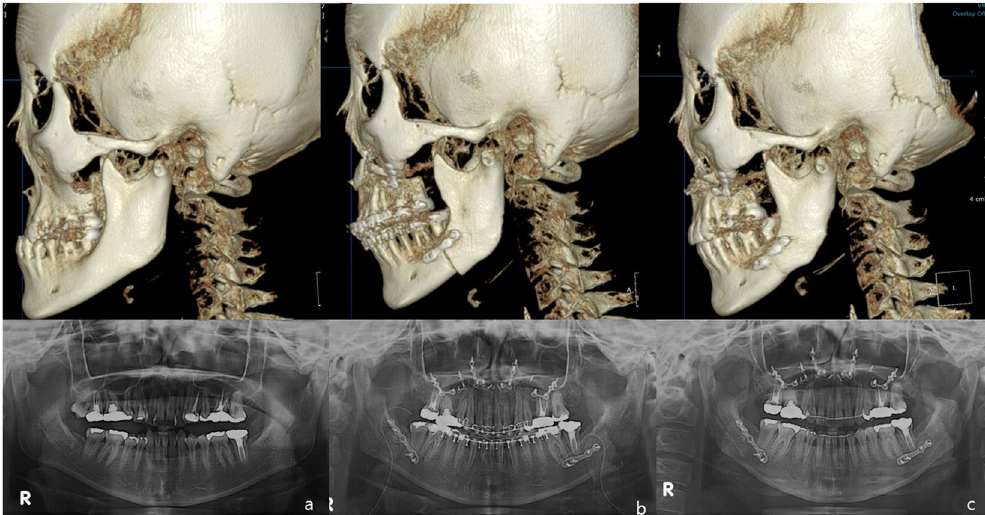
Figure 5. Three-dimensional ConeBeam CT and Panoramic radiographs demonstrating the use of a YK- plate after SSO. ( a ) Preoperative view, a 23-year-old patient with mandibular prognathism ( b ) 2 days after the operation, Bimaxillary operation was done. YK-plates were used on mandible ( c ) four months after the surgery, the bone remodeling is in progress, and the YK-plates are stable.